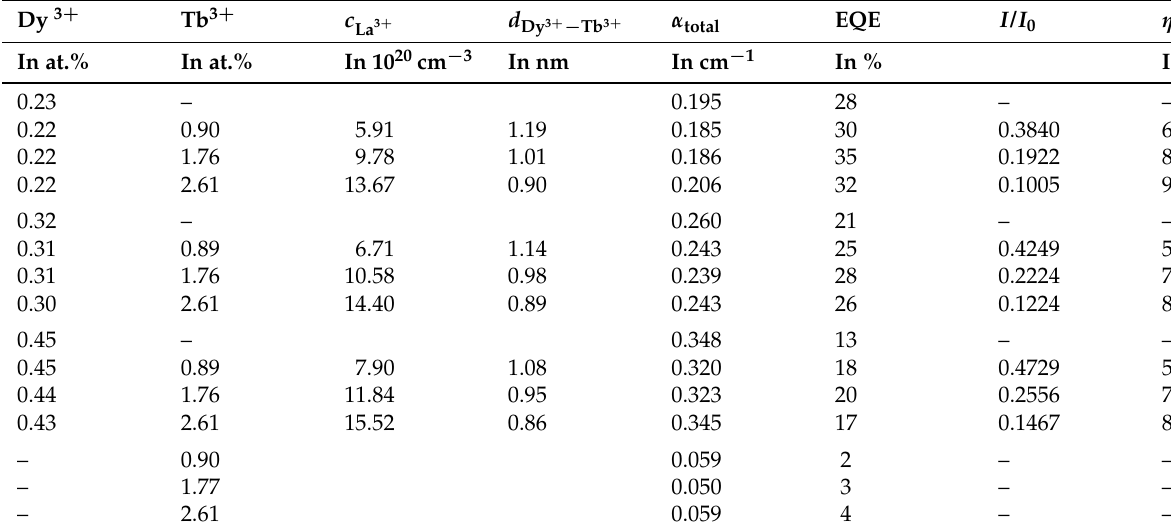
Table 2. Concentration of lanthanide ions, c absorption coefficients (including the glass background); and external quantum efficiencies of Dy 3 + and Tb 3 + single-doped as well as Dy 3 + /Tb 3 + double-doped BaB glasses at a wavelength of 452 nm. For the double-doped glasses, the ratios I / I 0 as well as the resulting energy transfer efficiencies, η T , are given.